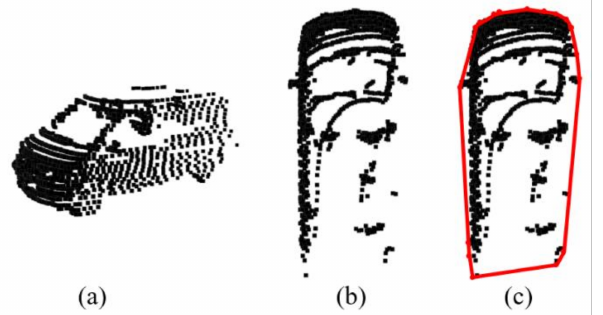
Figure 5. Convex hull extraction of obstacle vehicle point cloud: ( a ) the original 3D point cloud of the obstacle vehicle; ( b ) the bird’s eye view of the obstacle vehicle point cloud; ( c ) the convex hull point of the obstacle vehicle (red